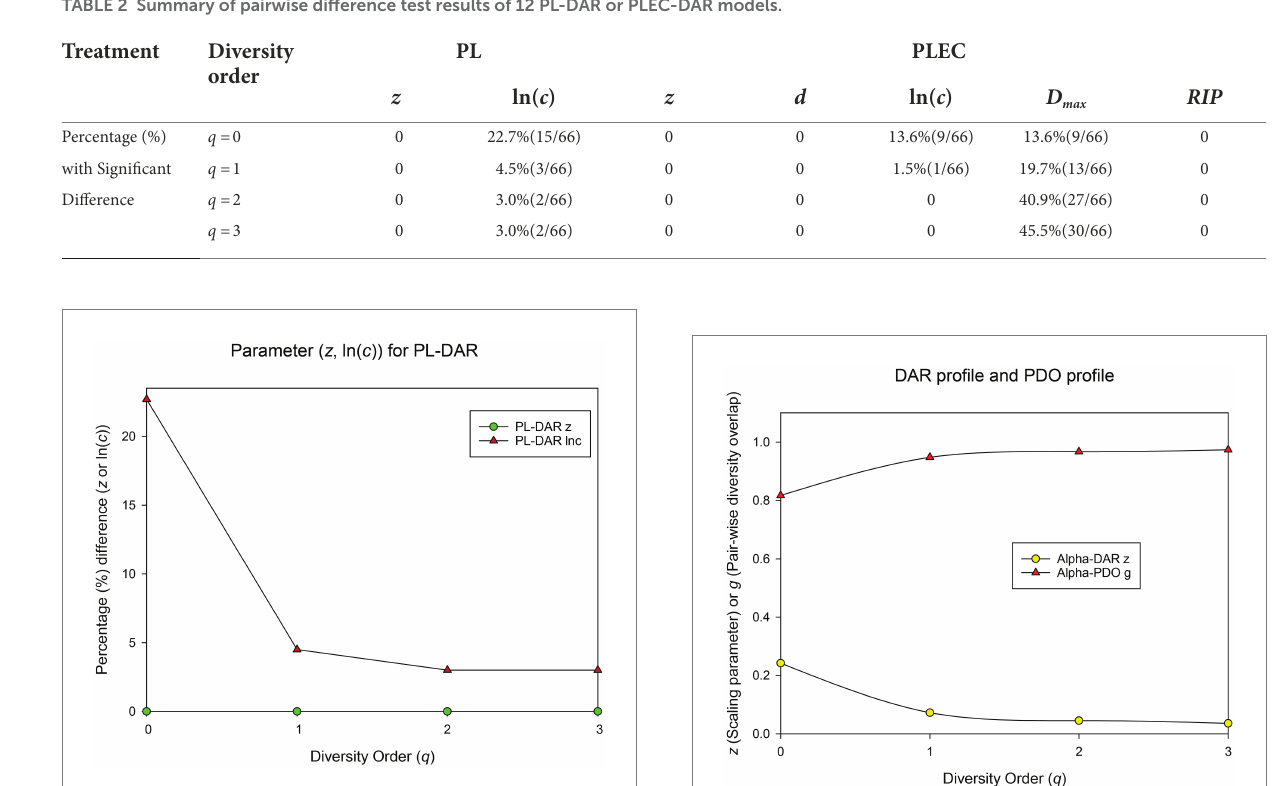
FIGURE 1 Results of randomization test: The percentage of pairwise comparisons with significant difference in the PL-DAR model parameters.